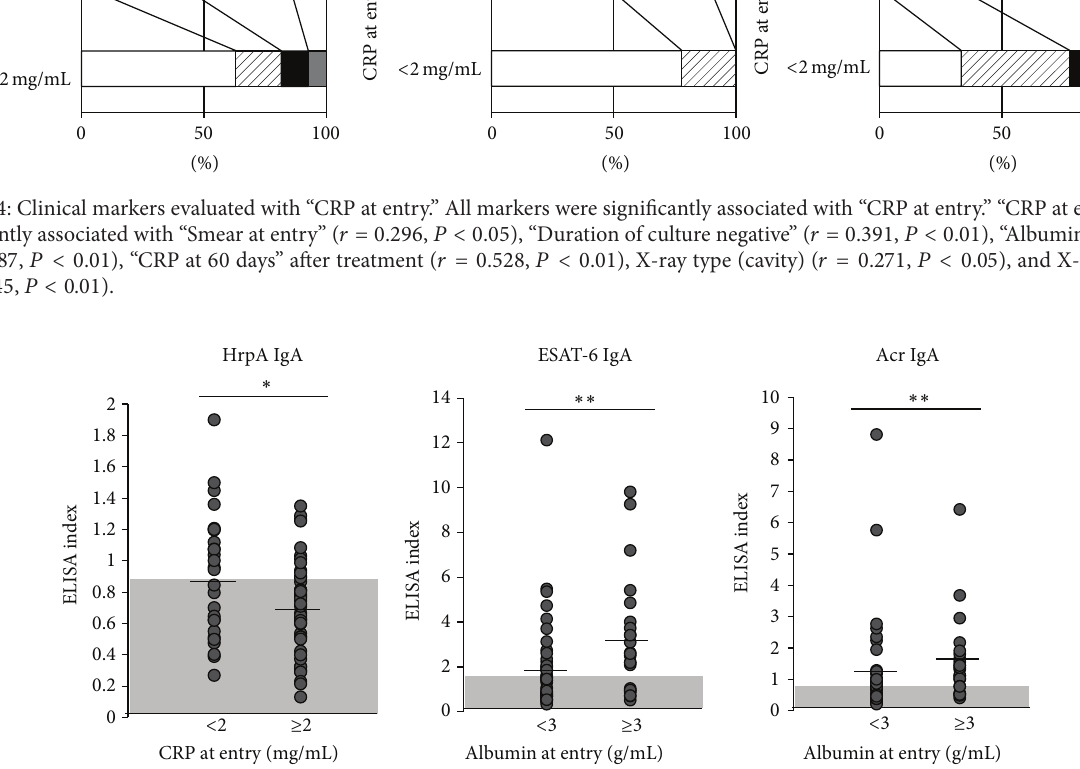
TBA61 (anti-Acr monoclonal IgA) and TBA68 (IgG of